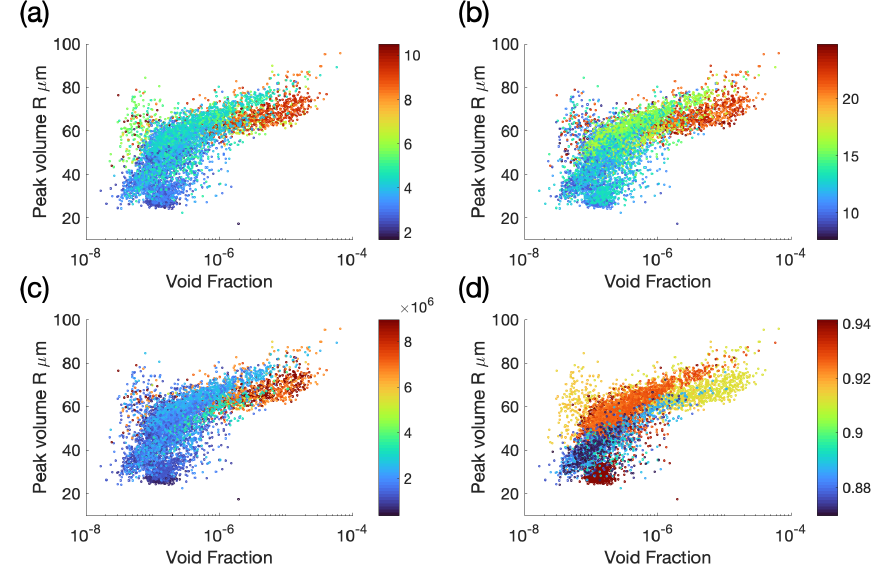
Figure C2. Aggregations of all the data shown in Fig. 7, but colour coded by (a) Significant wave height H s , (b) Wind speed ( U 10 ), (c) Wind- wave Reynolds Number ( Re ww ) and (d) estimated surface water oxygen saturation. The interpolated oxygen saturation is taken from CTD casts and so is only broadly representative of the general ocean surface on that day, and does not reflect local variations at the buoy location.